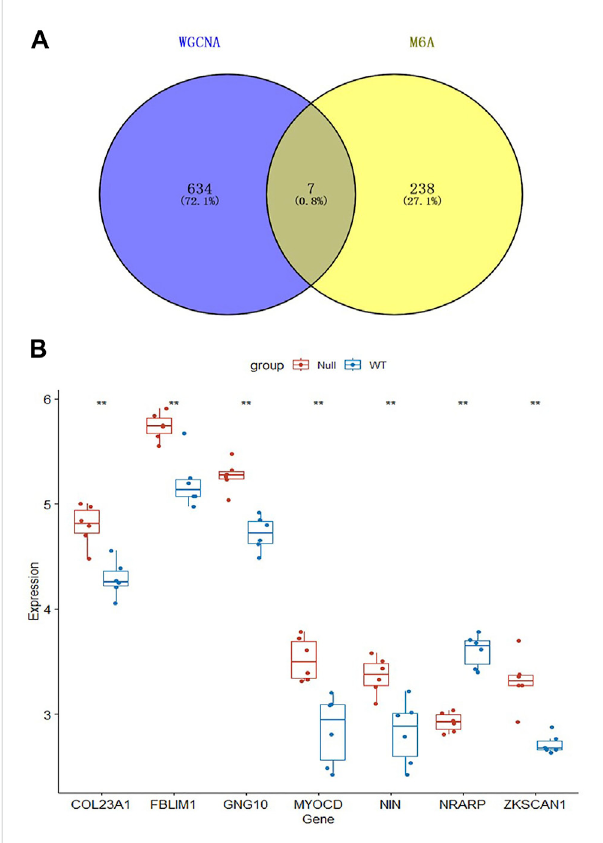
FIGURE 6 Screening and expression analysis of key genes. (A) Intersection of m6A-related DEGs with brown module genes. (B) Expression box plot of the seven key genes, Null represents RET knockout and WT represents Wide